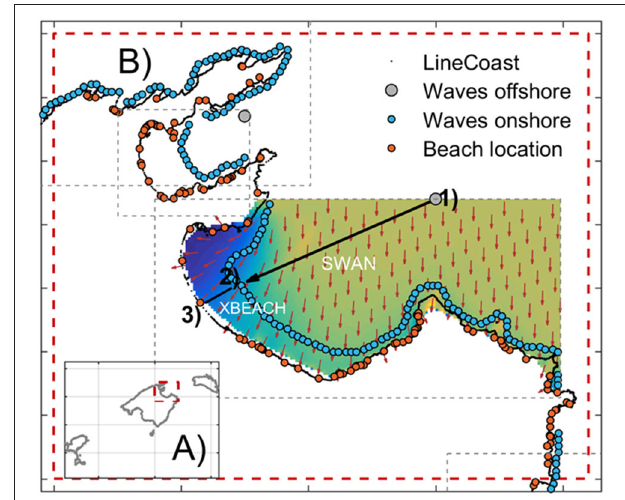
FIGURE 3 | Sketch of the strategy followed for obtaining the wave runup on the beaches from offshore wave climate model outputs. The deep-water model output at the closest grid point (1, grey dot) is propagated to shallow waters (2, blue dots) using SWAN. Then, the XBEACH model is forced with these data to produce the wave runup at beach locations (3, red